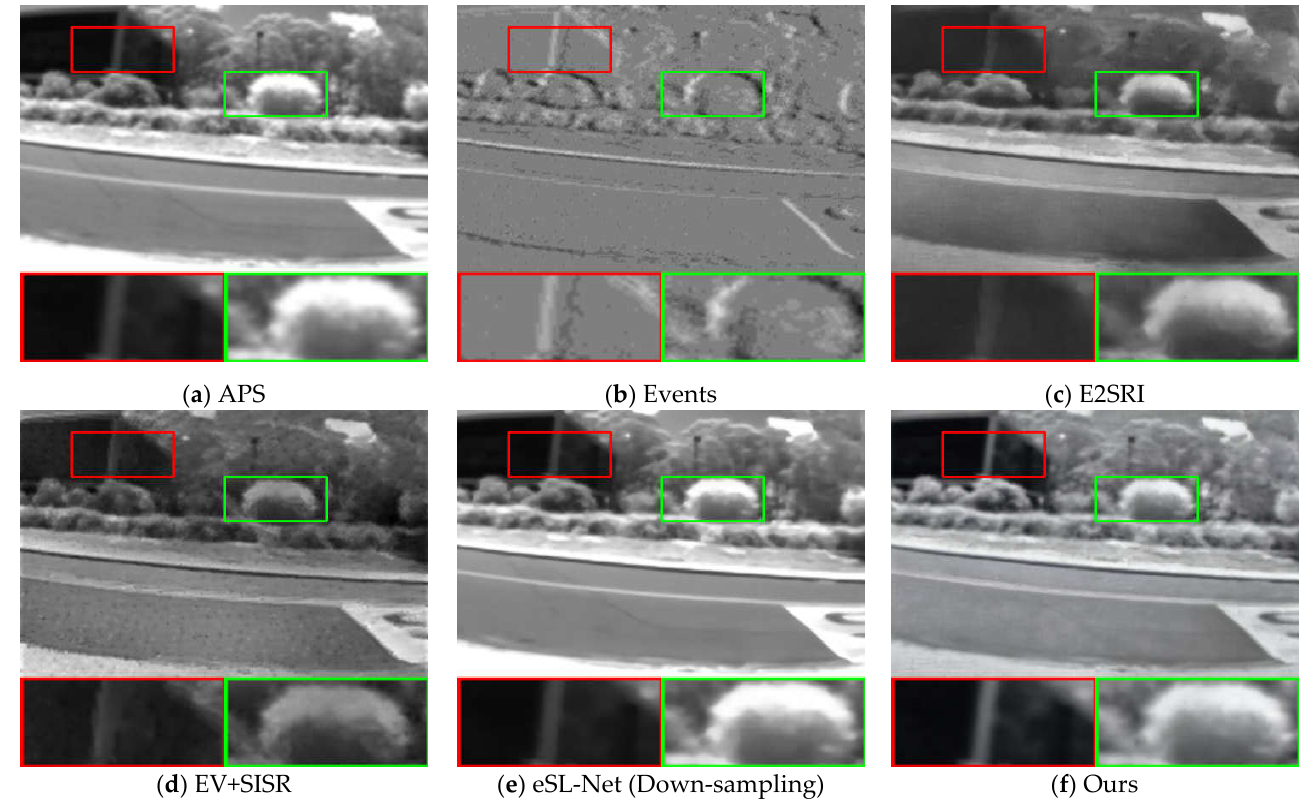
Figure 8. Comparison of the visual quality of our proposed method with other state-of-the-art methods for 2 × SR on real datasets. The APS frame is upsampled with bicubic interpolation to the corresponding scale for reference. The 4 × SR results of eSL-Net is downsampled with bicubic interpolation to the corresponding scale for reference.